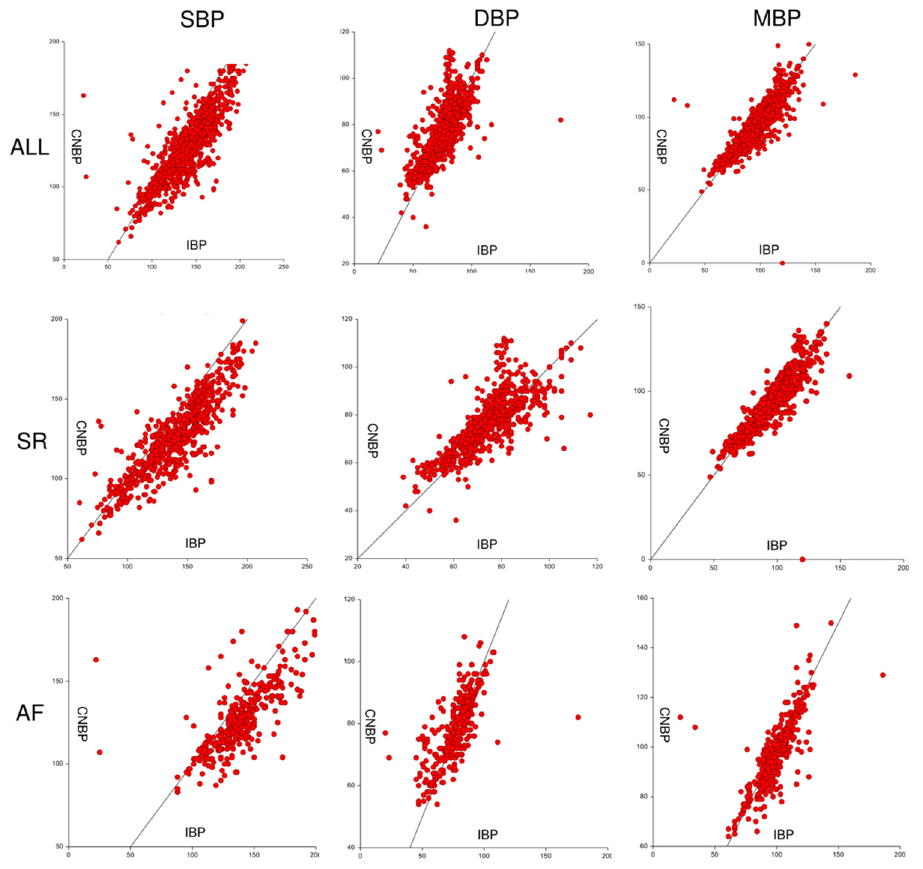
Figure 2. Correlation plots for systolic, diastolic, and mean blood pressure during sinus rhythm and atrial fibrillation. Values in mmHg. SR: sinus rhythm, AF: atrial fibrillation, SBP: systolic blood pressure, DBP: diastolic blood pressure, MBP: mean blood pressure, CBNP: continuous noninvasive blood pressure, IBP: invasive blood pressure.